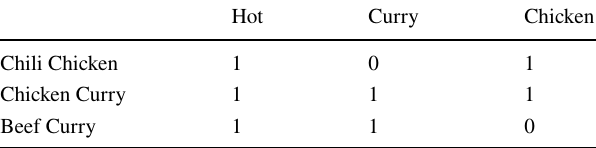
Table 1 Example of binary features